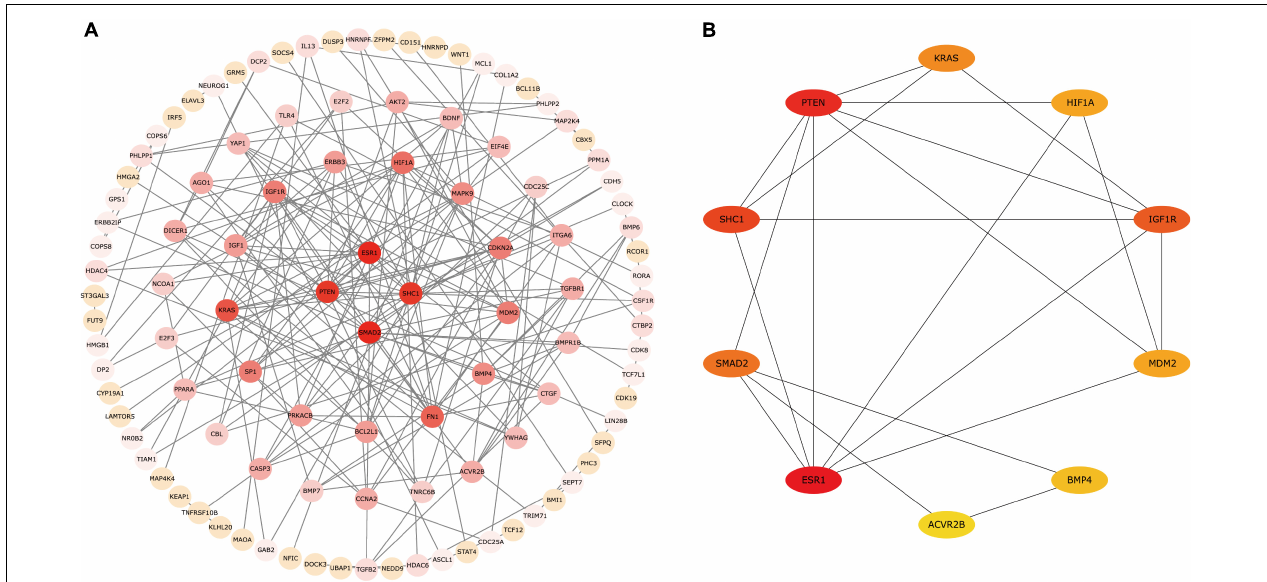
FIGURE 5 | The PPI network for 200 mRNAs. (A) A PPI network composed of 107 proteins and 200 edges. (B) The sub-network containing 10 hub genes. Proteins are plotted as circles and given different colors, the darker the color, the more important the protein is in the interaction network. PPI, protein–protein interaction.